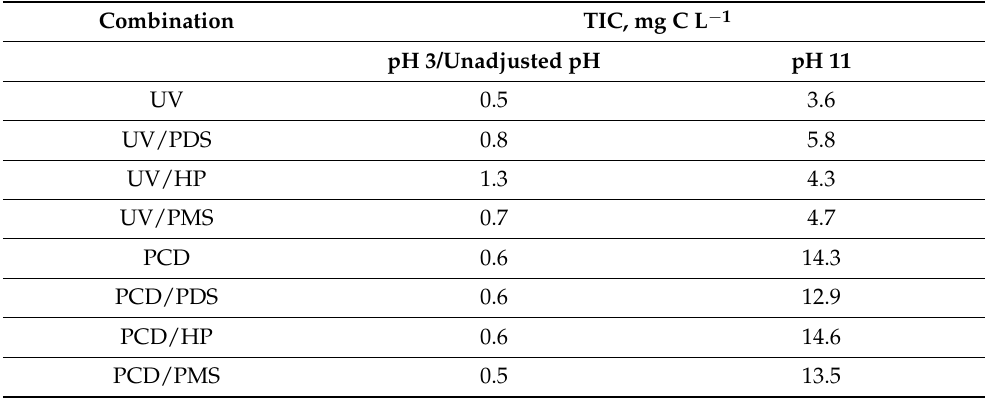
Table 1. Concentration of TIC in VMN solutions in 2 h of treatment dependent on pH values ([VMN] 0 = 13.5 µ M, [oxidant] 0 = 67.5 µ